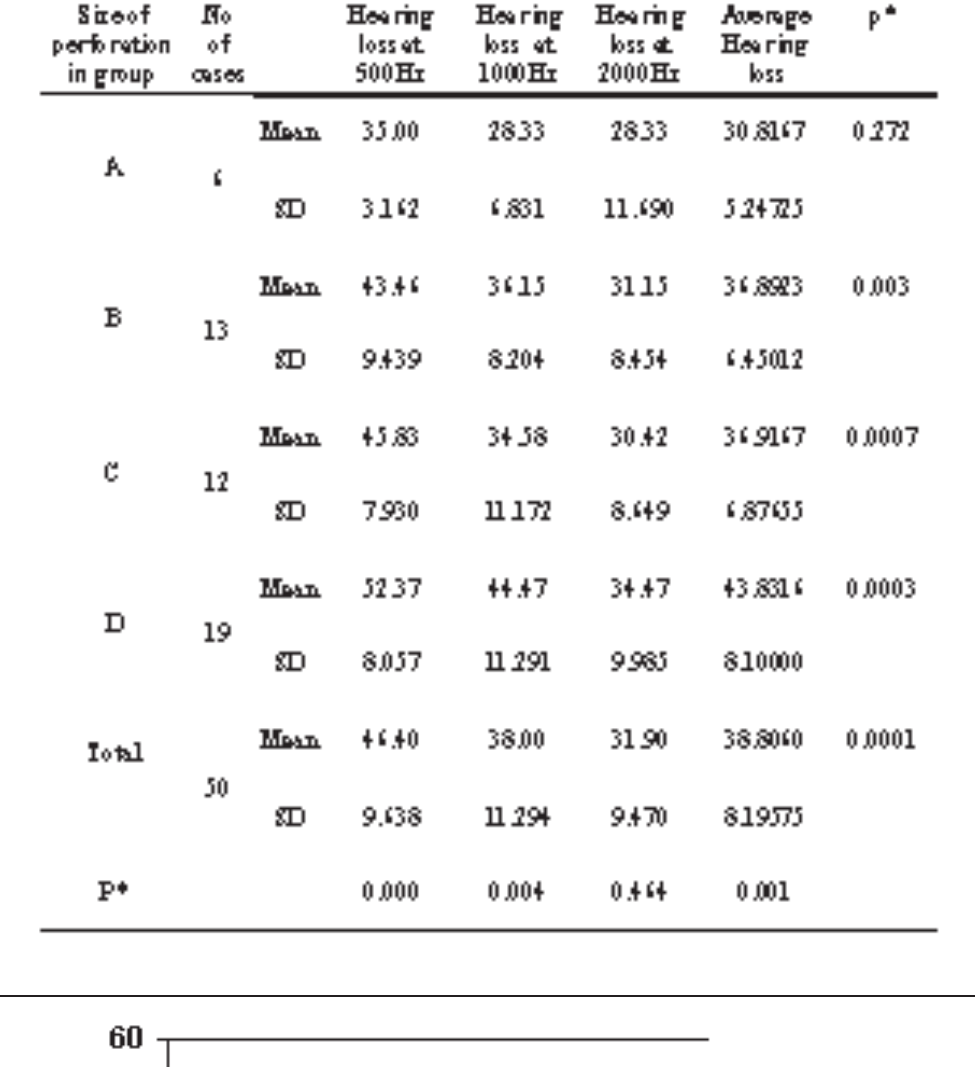
Table IV : Size of Perforation and Hearing Loss (n=50)